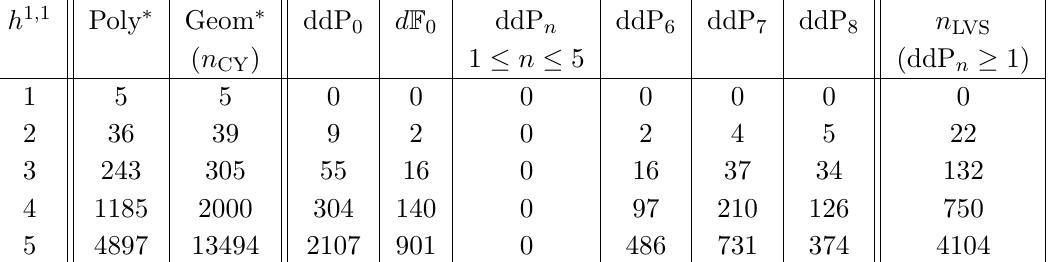
Table 9 . Number of CY geometries with a ‘diagonal’ del Pezzo divisor suitable for LVS.